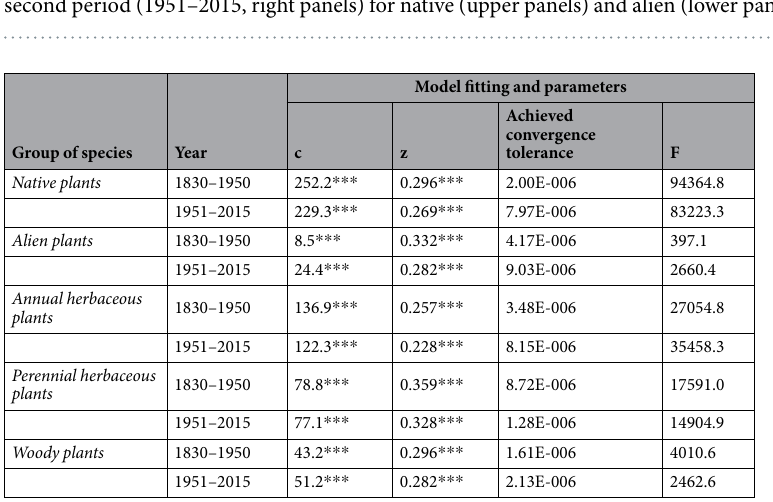
Table 1. Curve-fitting for the Island Species-Area Relationship (ISAR), based on the Arrhenius’ power function, calculated for plant species richness values of the Tuscan Archipelago islands (n = 16). Parameters (c and z) of the ISAR models are shown as well as the achieved convergence tolerance and F-value. Separate models were calculated for different groups of species based on their origin (native and alien) and functional types (annual herbaceous, perennial herbaceous, and woody) and for each study period. Significance